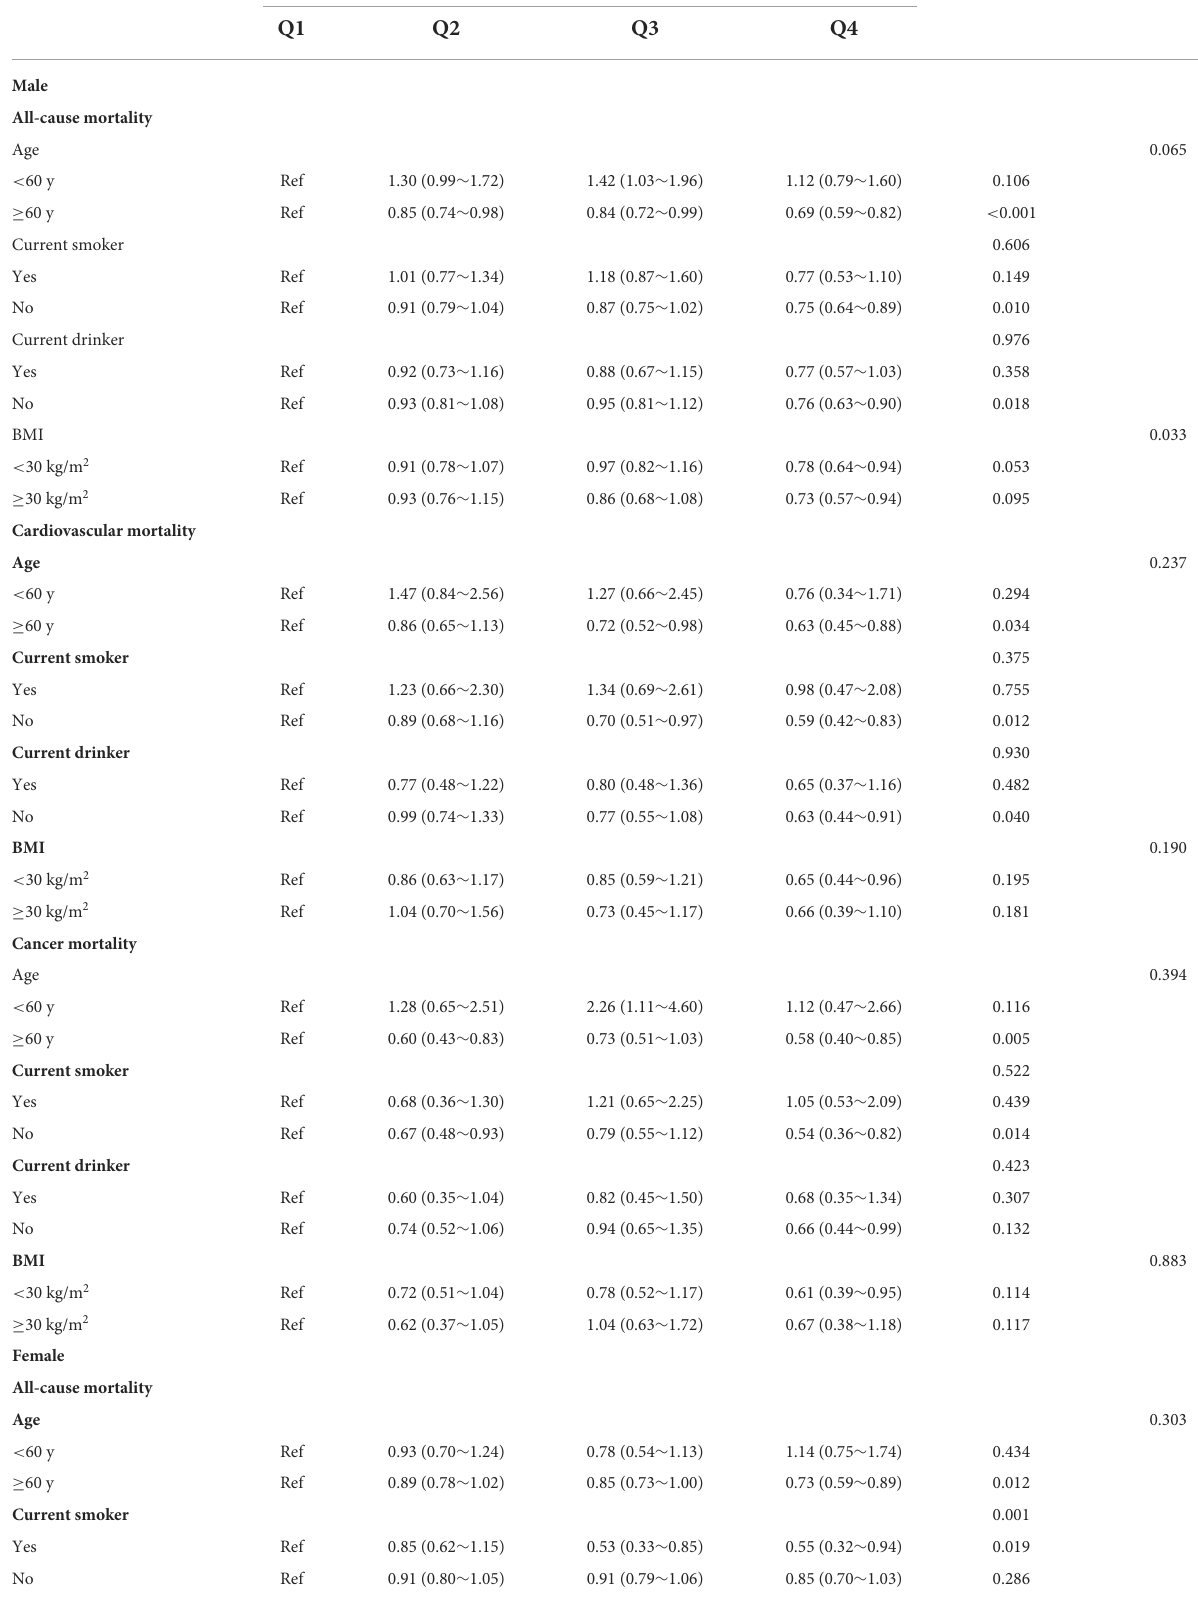
TABLE 3 Stratified analyses of the associations between dietary folate intake with all-cause and cause-specific mortality. Nutrient intake P